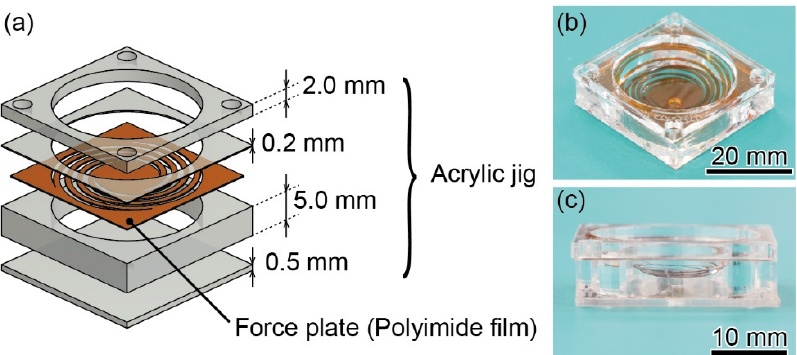
Figure 7. ( a ) Diagram of the assembly of the device ( b , c ) photographs of the assembled device.